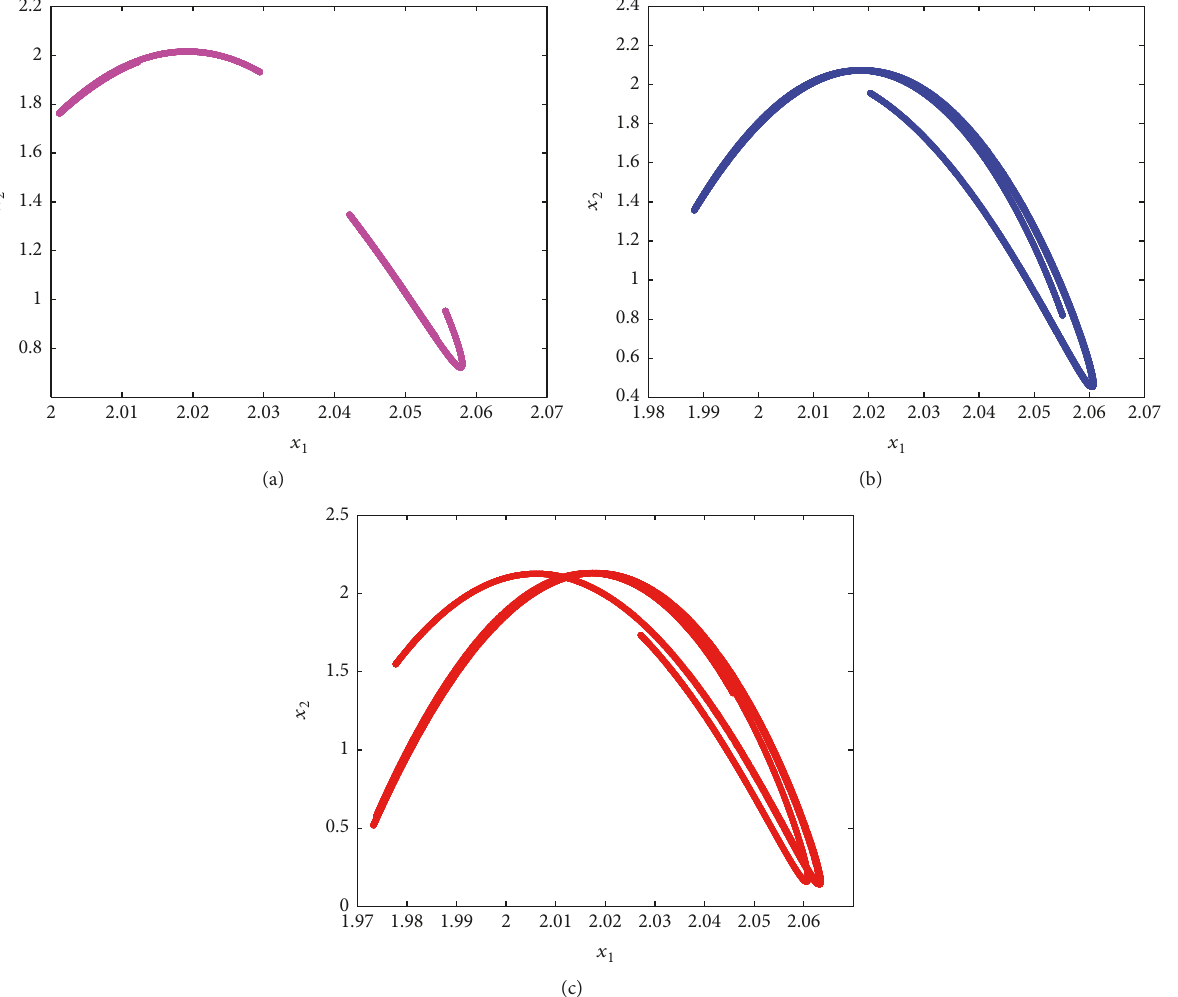
Figure 8: Chaos attractors for (a) (𝛼 1 = 0.42, 𝛼 2 = 1.26) ; (b) (𝛼 1 = 0.42, 𝛼 2 = 1.34) ; (c) (𝛼 1 = 0.42, 𝛼 2 = 1.42)